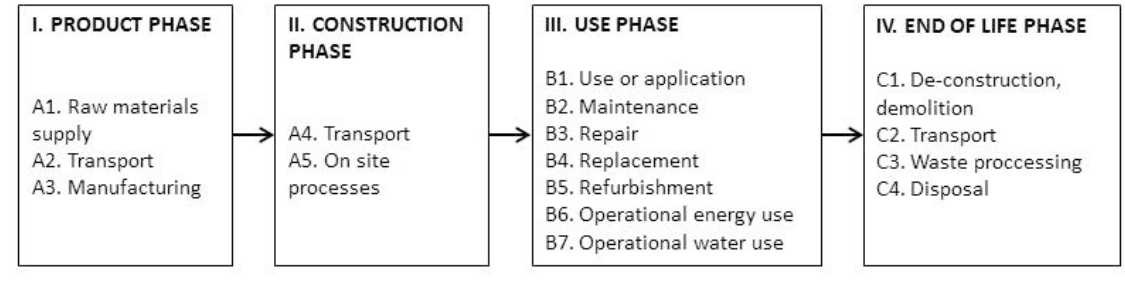
Figure 1. Building stages defined by EN 15978